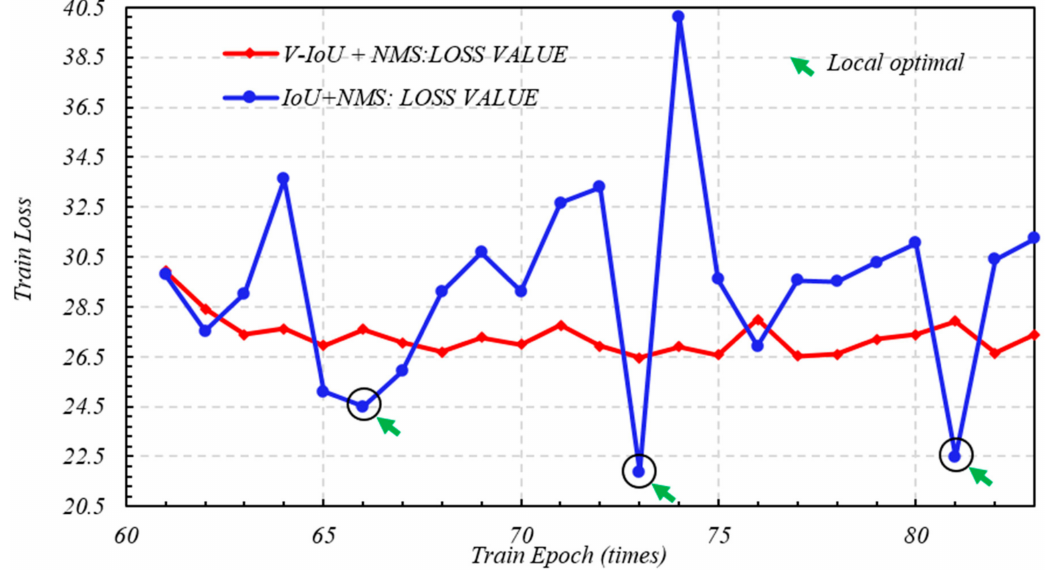
Figure 10. V-IoU versus IoU training loss (epoch: 60 to